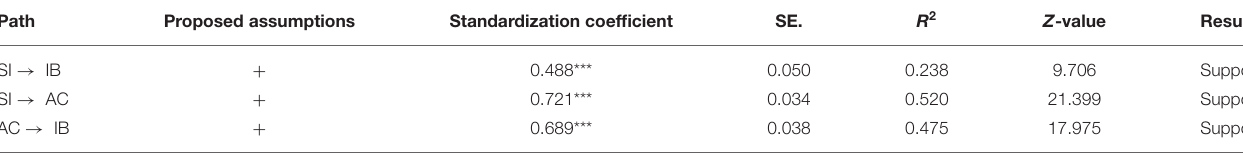
TABLE 5 | Main effect analysis.